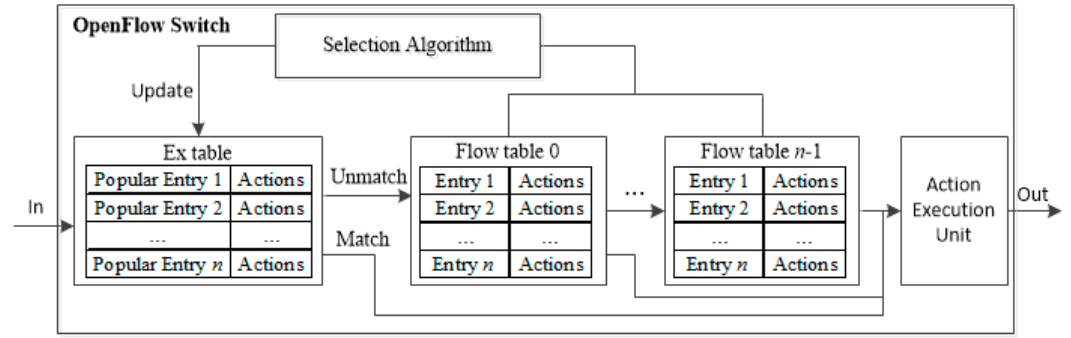
Figure 3. The structure of the proposed scheme.